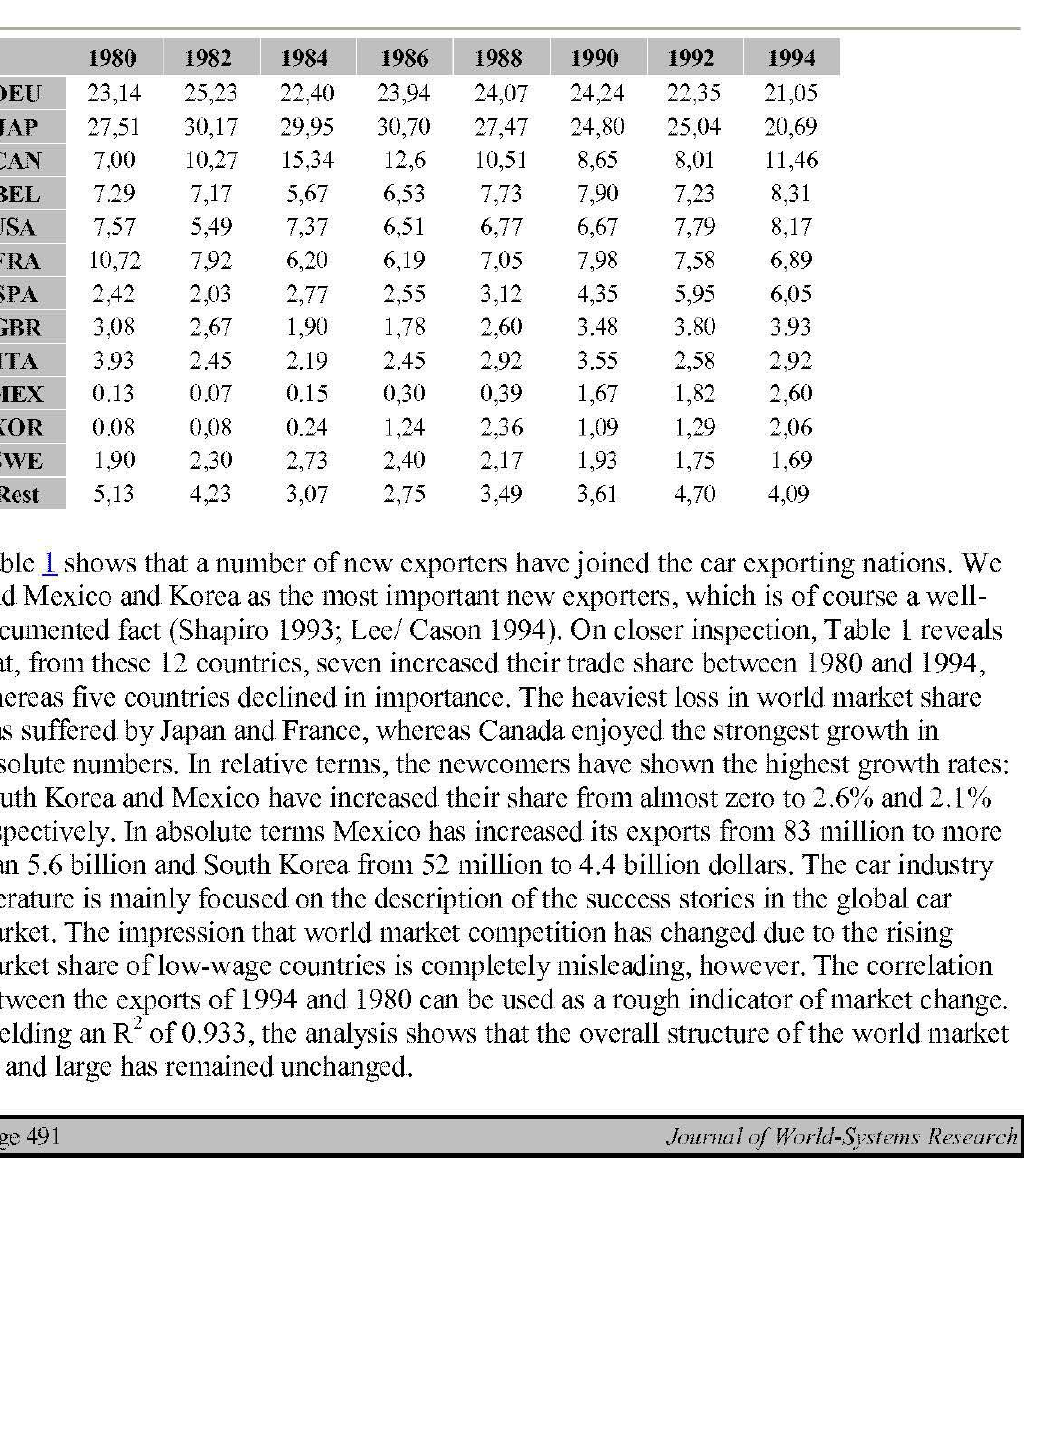
Table 1:Share of World Trade in Pa-;senger Cars by Value (in%) in Selected